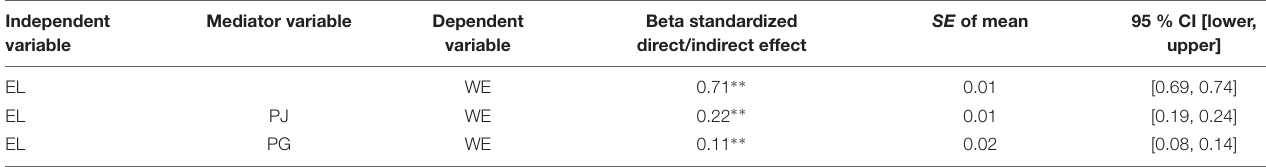
TABLE 3 | Bootstrap analysis of the magnitude and statistical significance of the direct and indirect effects.